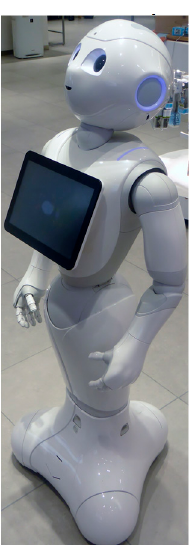
Figure 4. Pepper by Aldebaran Robotics and SoftBank. Public domain image from Wikipedia.